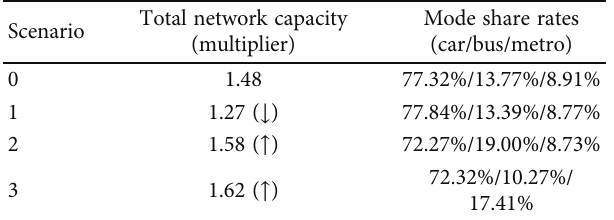
Table 4: Network capacity evaluations under di ff erent scenarios.